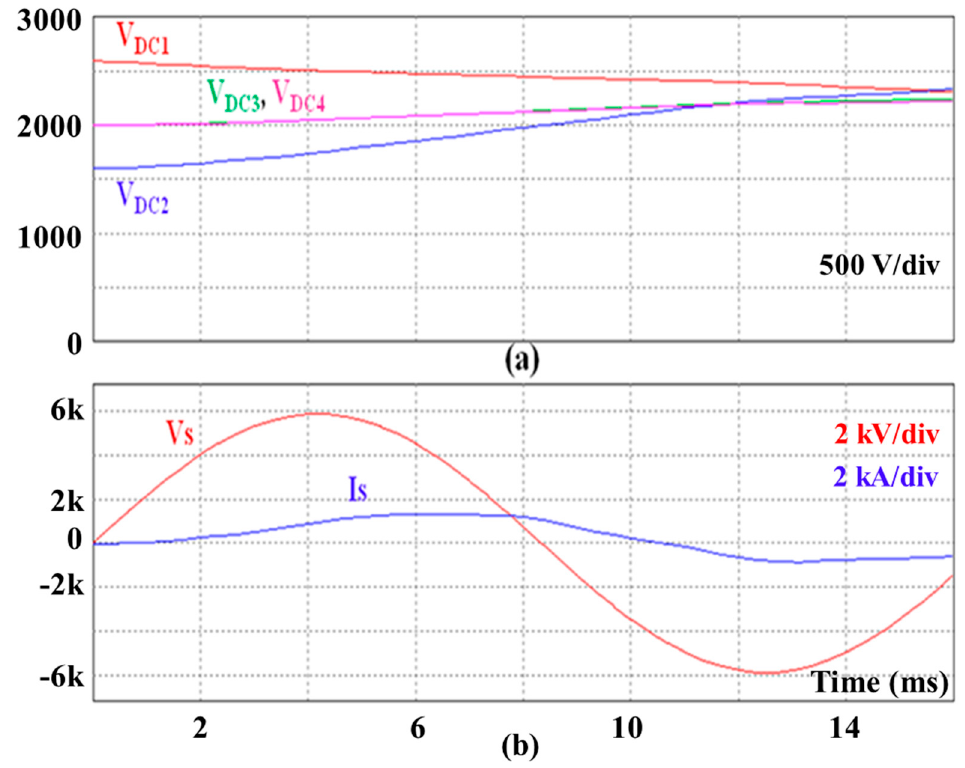
Figure 10. Simulation waveforms of the five-level OCC MV Regen-Load with unbalanced dc-link capacitor voltages. ( a ) Four dc-link capacitor voltages; ( b ) Input line voltage and input line current. From this simulation, each dc-link capacitor voltage V DC 1 – V DC 4 is 4 kVdc to